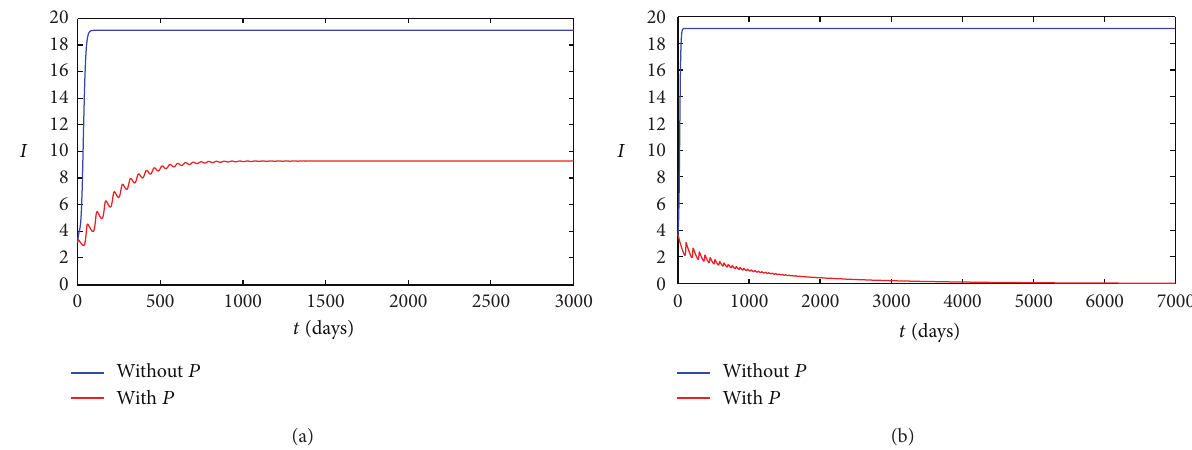
Figure 6: The population densities of the infected hosts with and without vector